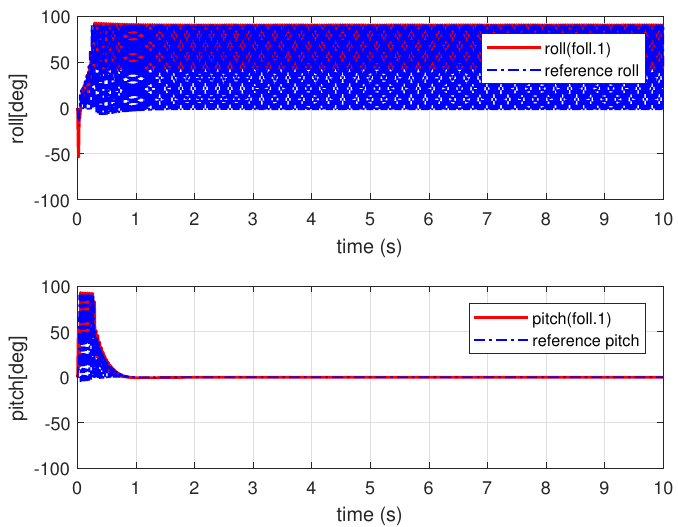
Figure 20. The reference angles of the first follower quadrotors for the formation control about the 6 π circular trajectory: The dashed line indicates the reference attitude angles that enable the first follower quadrotor to converge to the desired formation, and the solid line is the result of the simulation about attitude responses of the first follower quadrotors.